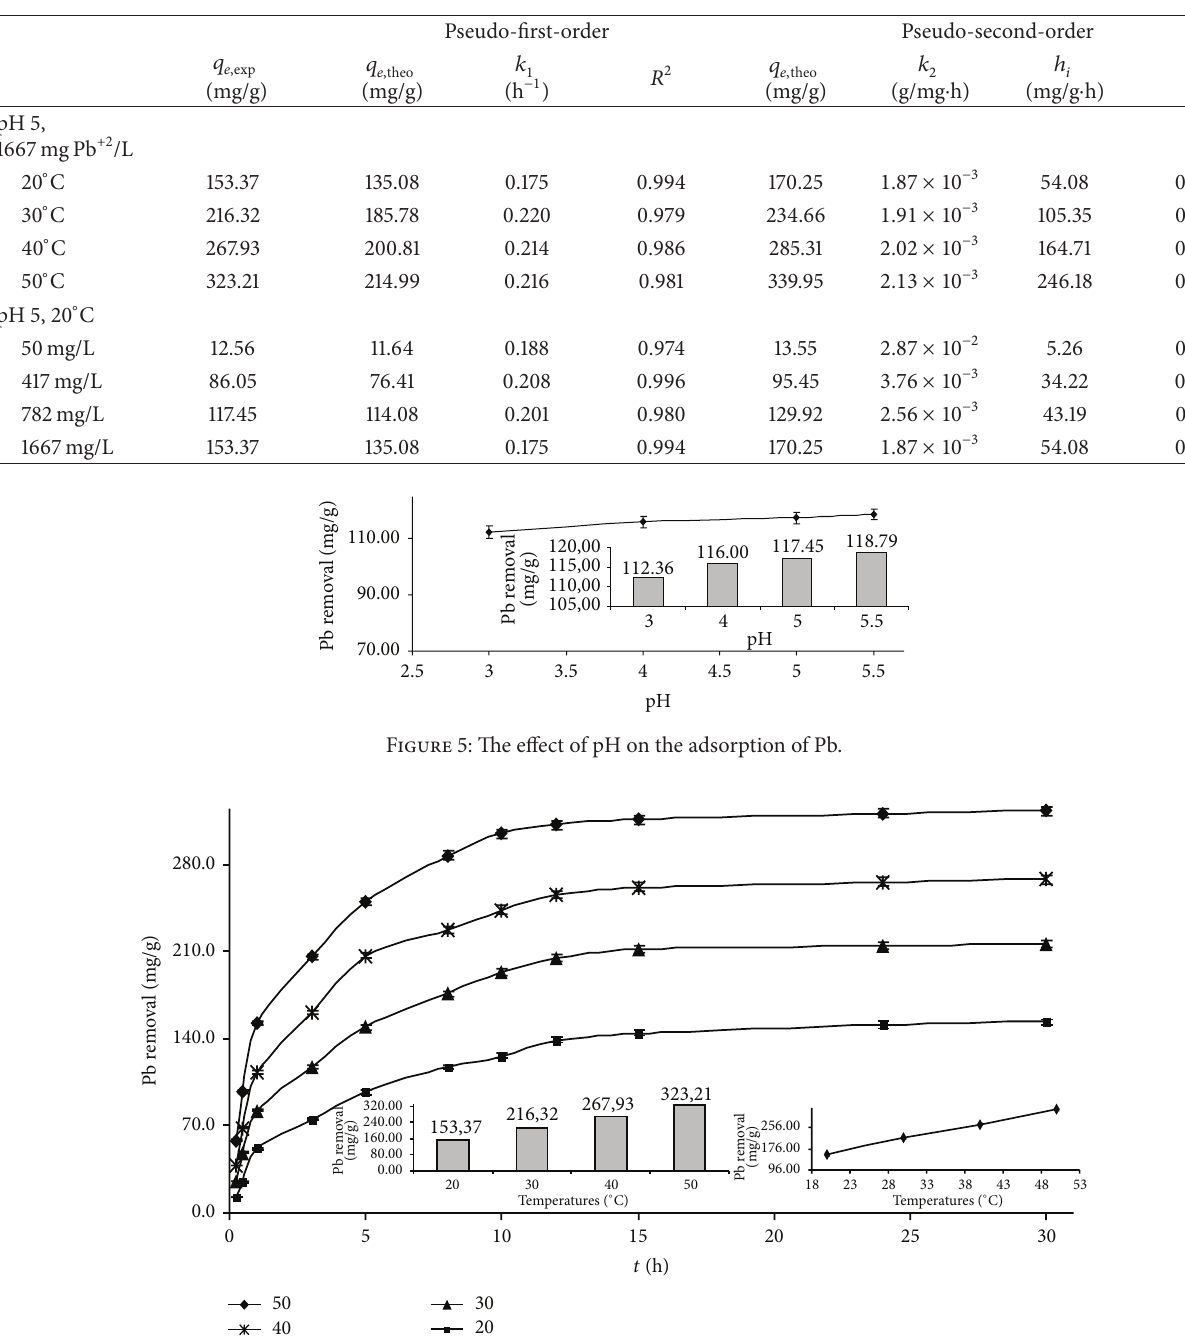
Table 5: Pseudo-first and second-order kinetic constants of Pb (II) at different temperatures and concentrations.